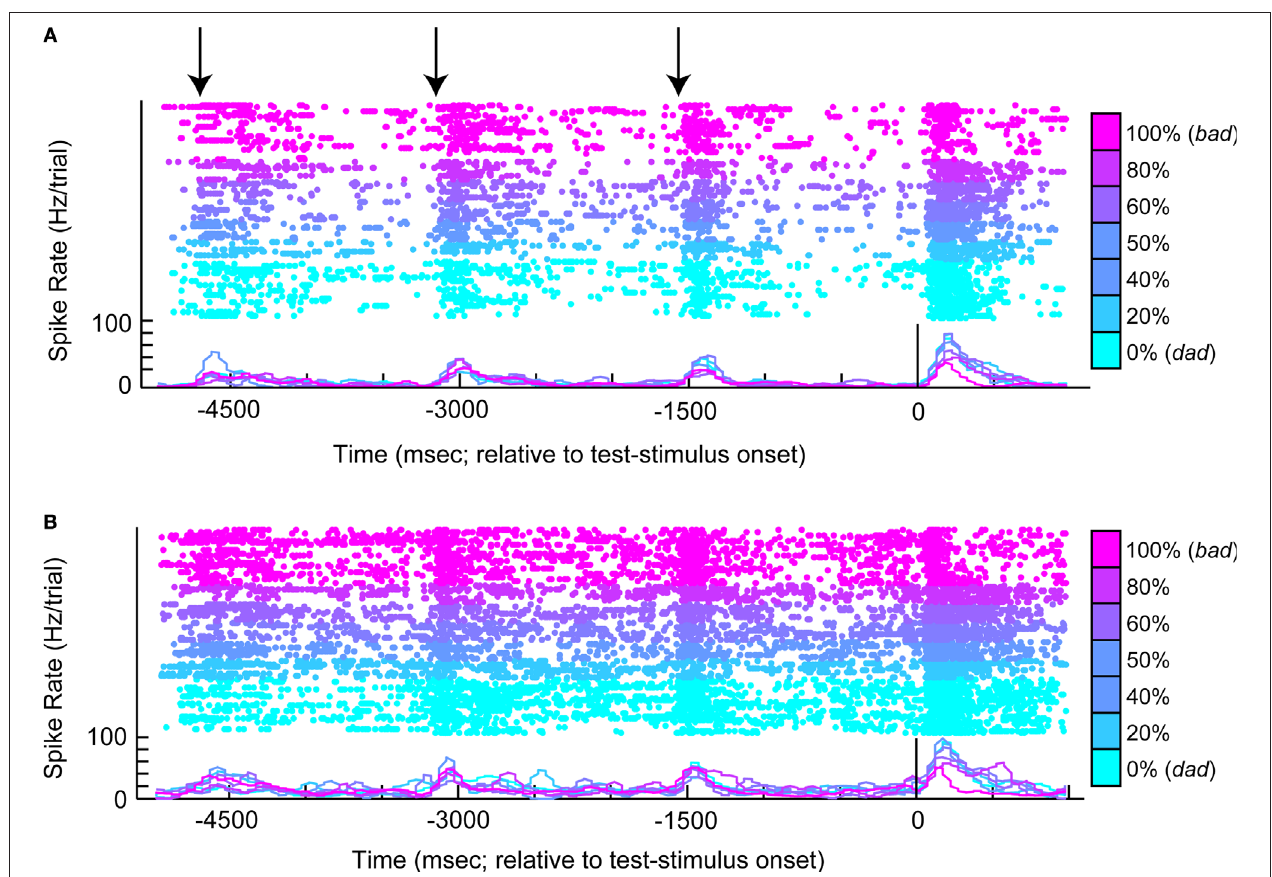
FIGURE 3 | An example of neural activity from a single vPFC neuron during the same-different task. In (A) , the reference stimulus was the prototype spoken word bad . In (B) , the reference stimulus was the prototype spoken word dad . For both panels, the rasters and spike-density histograms are aligned relative to the onset of the test stimulus. The morph value of the test stimulus is